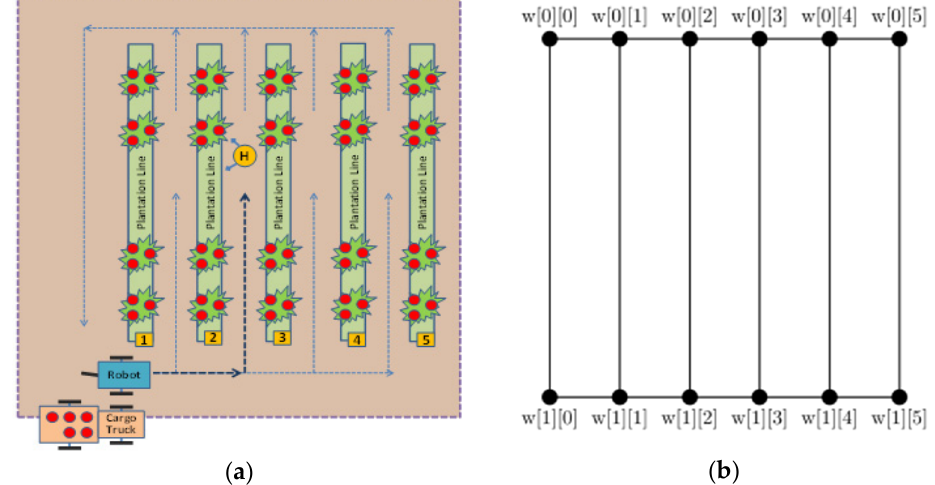
Figure 4. ( a ) The plan of a field consisting of five parallel plantation lines; ( b ) The grid modeling this field, containing 6 lanes, 2 sides and 12 waypoints. The vehicle is allowed to move only on lanes and sides, and any path between two points reduces to a sequence of intermediate waypoints.